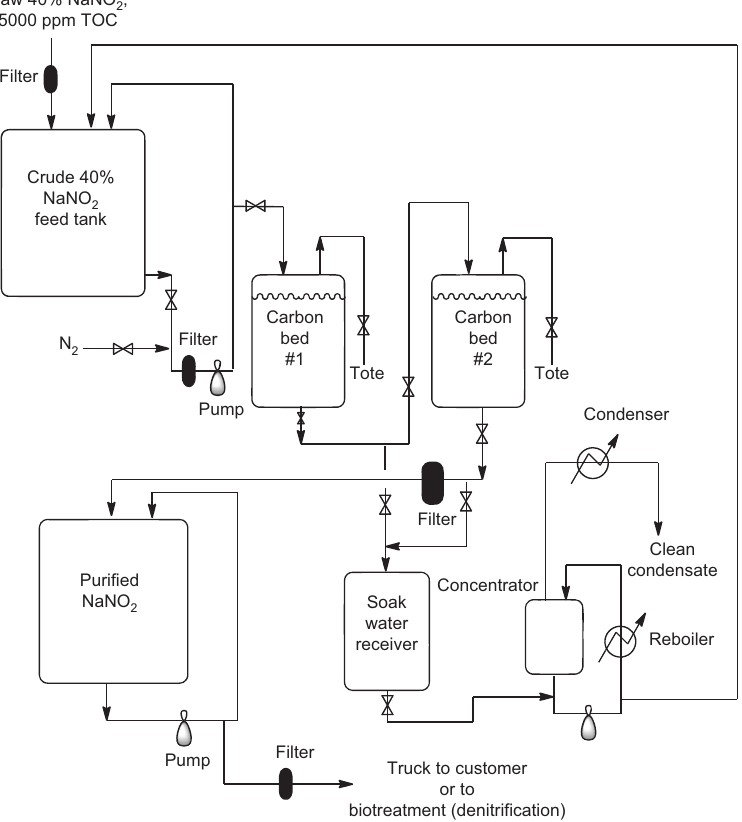
Figure 5 Simplified process diagram for the carbon purification of raw 40 wt% aqueous NaNO